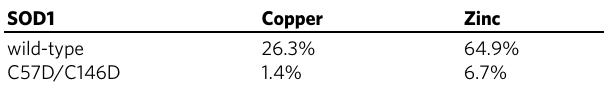
Table 1 Copper and zinc content analysis of wild-type and C57D/C146D mutant SOD1 proteins revealed by